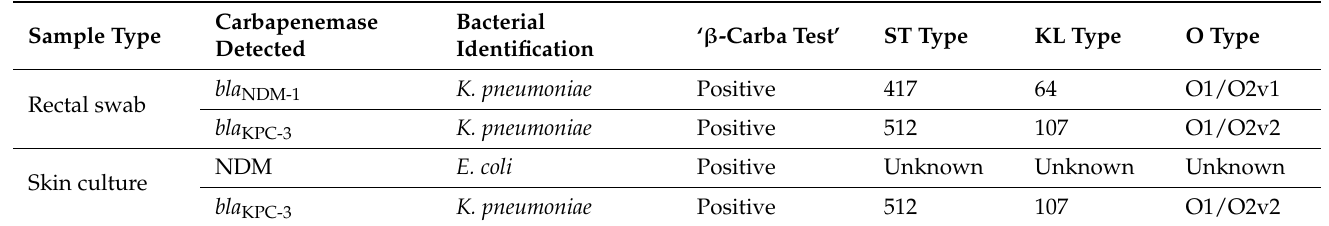
Table 1. Summary of results for patient in Case Study 1—CPE positive bacteria, isolated in the point prevalence study performed by the National Centre for Infection Control (NCIC).